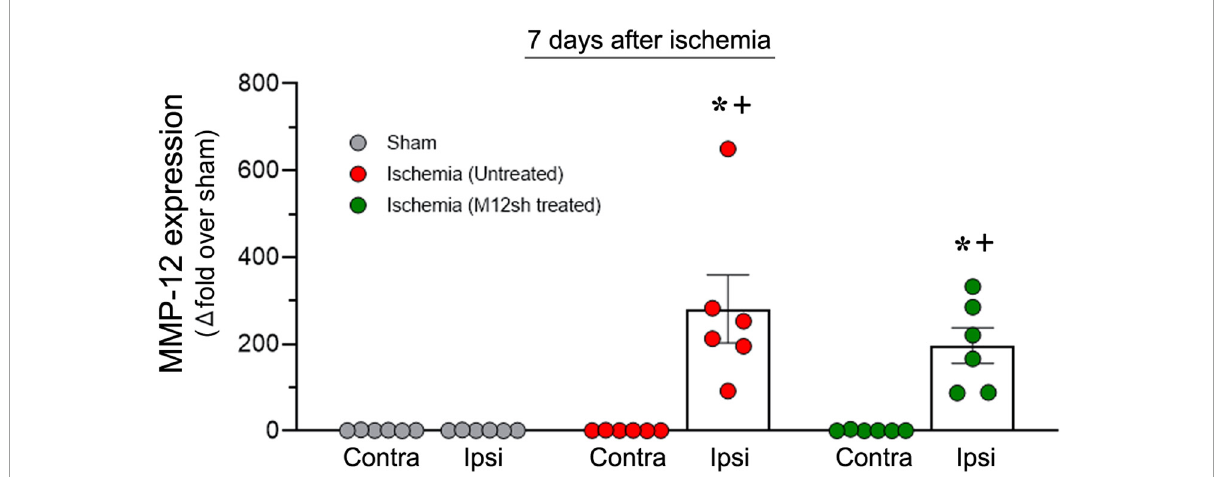
FIGURE4 Duration of the effect of a single-dose M12sh treatment on MMP-12 expression in the brain. The column scatter plot shows the quantified mRNA expression of MMP-12 (expressed as fold change over sham) on post-reperfusion days 7 in the contralateral (Contra) and ipsilateral (Ipsi) brain hemispheres of male rats subjected to 2-h transient focal cerebral ischemia. Statistical analysis: Two-way ANOVA followed by Sidak’s/Tukey’s multiple comparisons tests. + p < 0.05 vs. Contralateral brain hemisphere (same experimental group). * p < 0.05 vs. Sham group (same brain